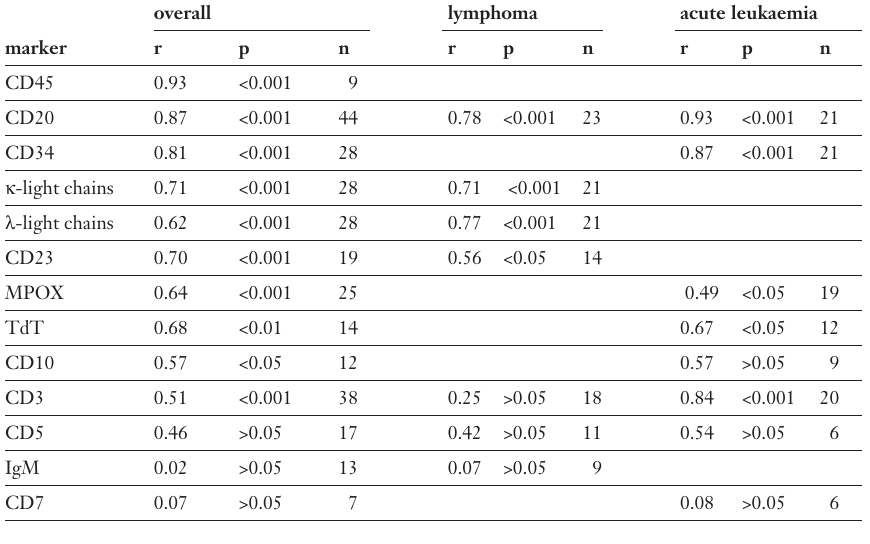
Epitope detection between IHC and FC according to semiquantified immunoreactivity (0 = <10%, 1 = 10–30%, 2 = 30–80%, 3 = >80%). All markers. Areas of circles represent the number of events.